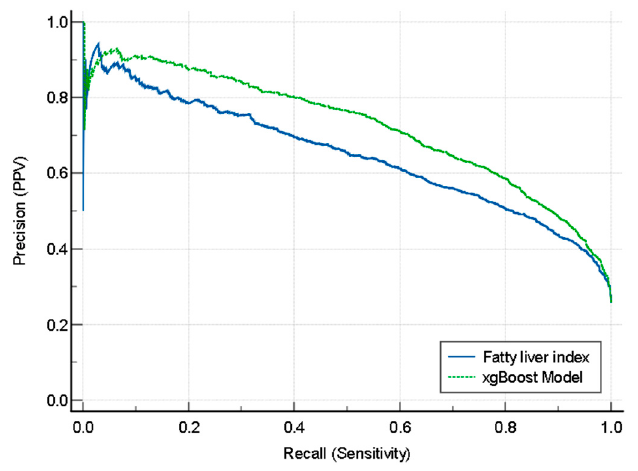
Figure 3. Comparison of the precision–recall curve of the xgBoost model and fatty liver index.